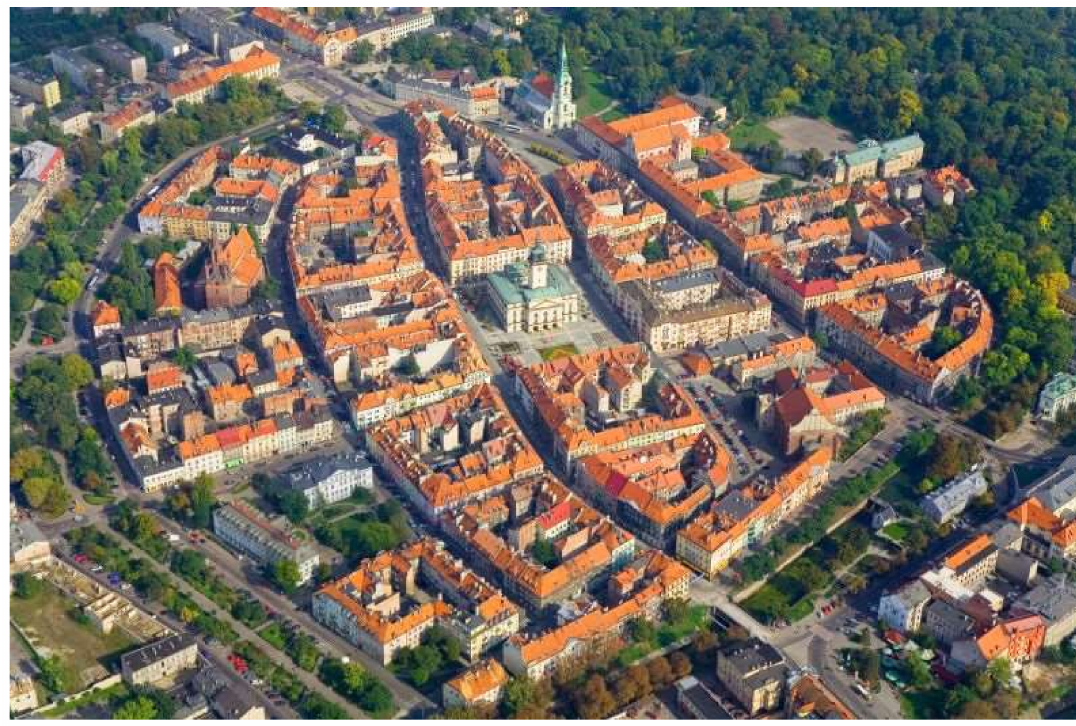
Figure 3. The reconstructed medieval core of Kalisz with its grid street structure. Photo: Styl Suwałki. Available online: https://turystyka.wp.pl/kalisz-atrakcje-najstarszego-miasta-polski-i-jego-okolic- 6043990396179073g (accessed on 1 March 2018), reproduced with permission from the Archiwum Urz˛edu Miasta Kalisza (Archive of Kalisz Municipal